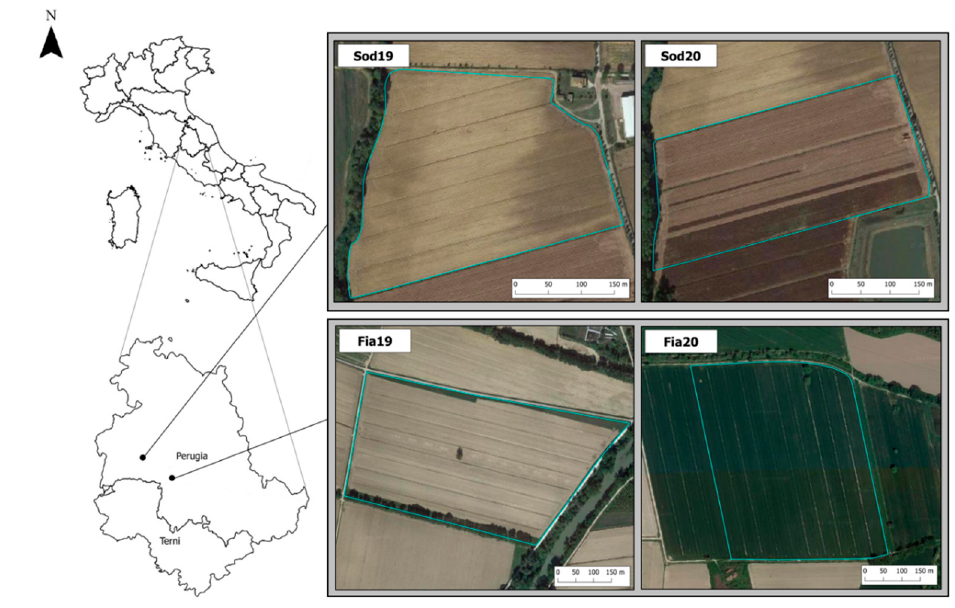
Figure 1. Geographical location of the study areas and experimental fields (outlined in cyan). Table 1. Location, coordinates, altimetry, extent, variety, sowing date, and previous crops of the experimental fields, as well as second N application date.